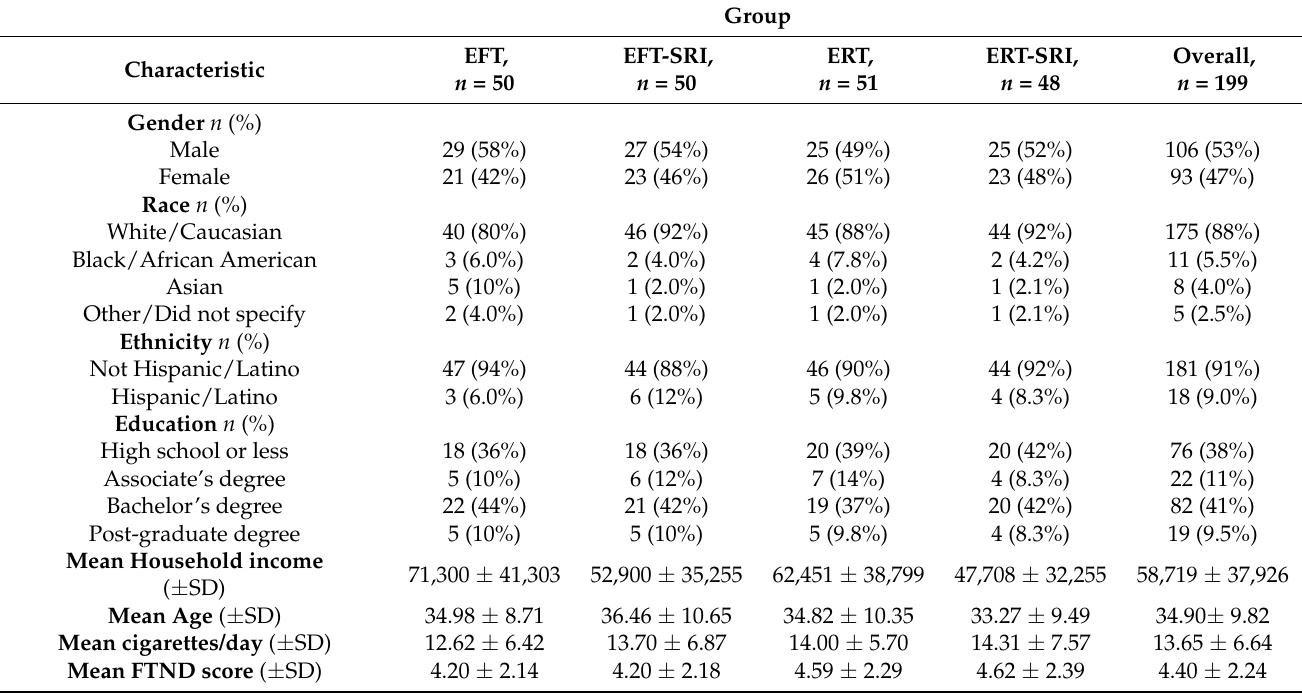
Table 1. Participant